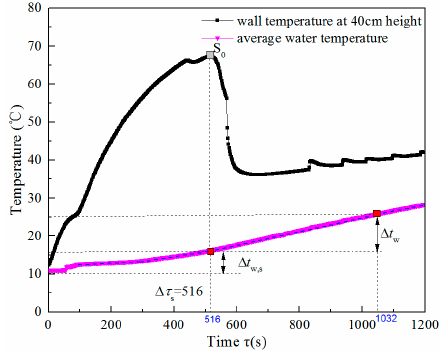
Figure 9. Variation of water temperature over time for the deionized water heat pipe.